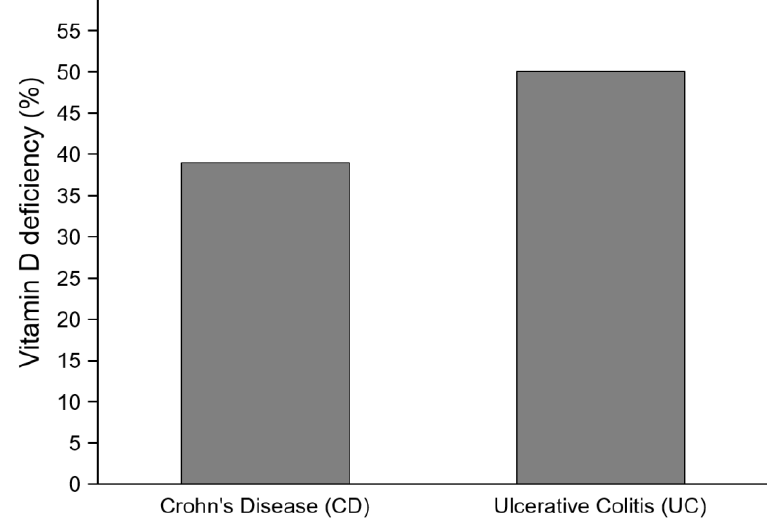
Figure 2. Percentages of patients with vitamin D deficiency.